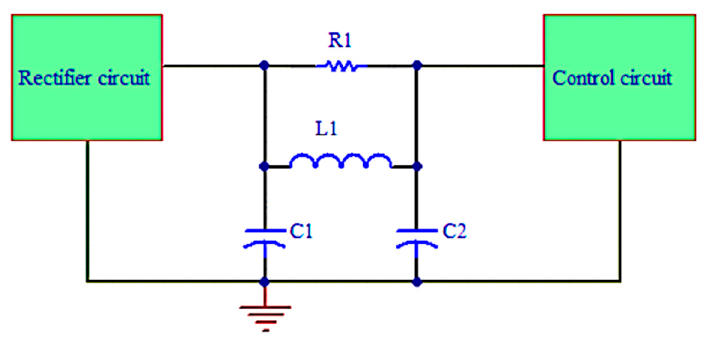
Figure 6. Filter circuit in the LED drive circuit (Sample A).